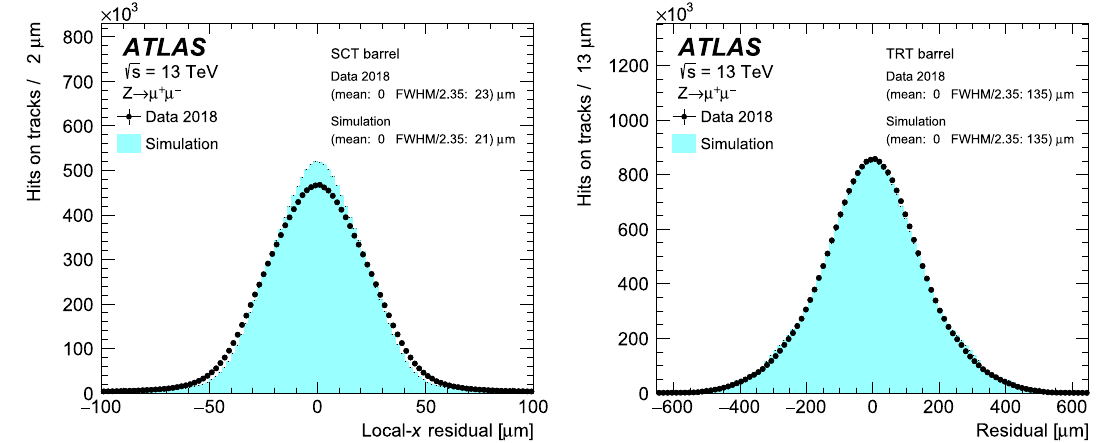
Fig. 6 The local- x residual distributions in the SCT (left) and TRT (right) for the Z → μ + μ − data sample compared with simulated data. The distributions are integrated over all hits on tracks in barrel